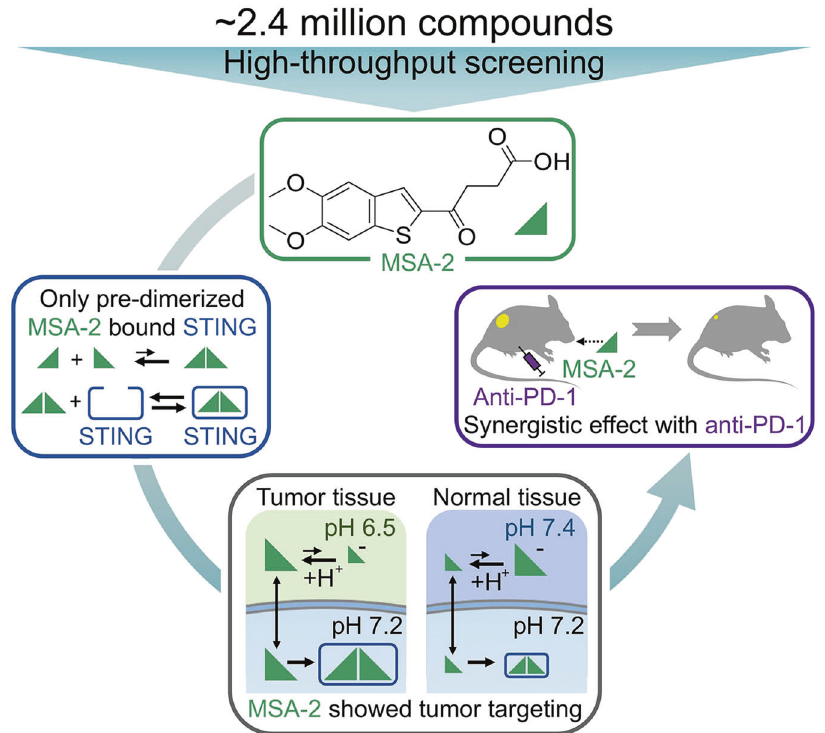
Fig. 1 Through high-throughput screening, MSA-2 was identi fi ed as a promising STING agonist from ~2.4 million compounds. Only pre-dimerized MSA-2 could bind to STING. In the acidic tumor microenvironment, uncharged MSA-2 showed a higher permeable ability and thus preferentially activated STING compared to normal tissues. Oral administration of MSA-2 exhibited excellent safety tolerance and synergetic antitumor effects with anti-PD-1 therapy in